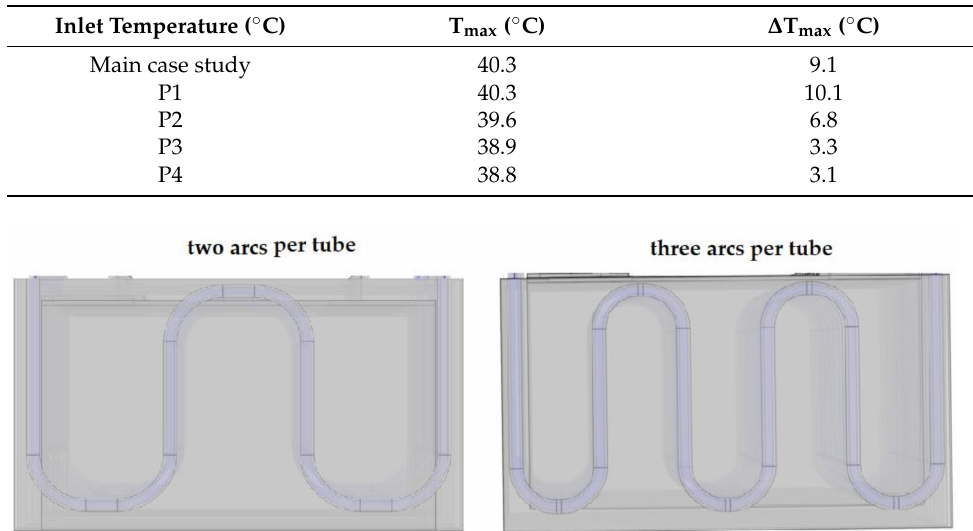
Figure 17. The temperature distribution of the module with different inlet and outlet positions. Table 7. The thermal performance of the system with different inlet and outlet positions.